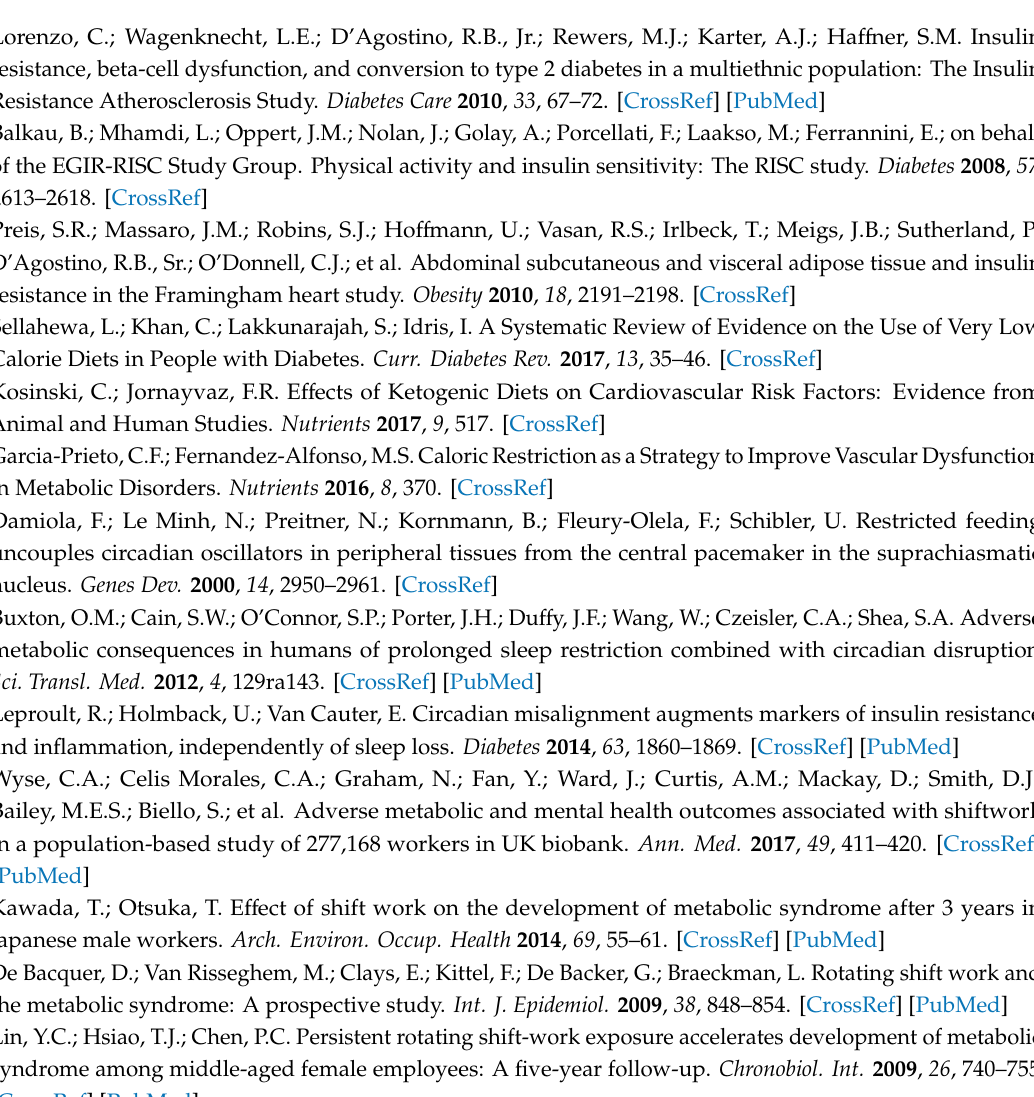
Table S1: Associations between insulin sensitivity estimated using the Matsuda Index calculated with 300 minutes and dietary proportion variables using linear regression models ( n = 40). Table S2: Associations between insulin sensitivity and dietary proportion variables using linear regression models in those whose habitual wake time is earlier than start of OGTT ( n =